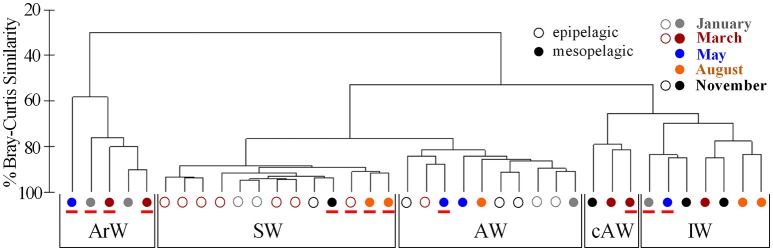
Hierarchical cluster analysis of Bray-Curtis similarities, based on the diversity of Thaumarchaeota sequences from Illumina amplicon sequencing of 16S rRNA genes, illustrating the distribution of samples into five groups. These five groups are labeled according to water mass specificities of the samples within the groups (ArW, Arctic Water; SW, Surface Water; AW, Atlantic Water; cAW, cold Atlantic Water; IW, Intermediate Water). Samples with a mismatch between their associated water mass group and the physical water mass of their sampling origin are marked with a red line. The sampling month is given by colors. Samples were further distinguished according to depth, with open circles for epipelagic samples (0–200 m; n = 16) and filled circles for mesopelagic samples (200–1,000 m; n = 22).